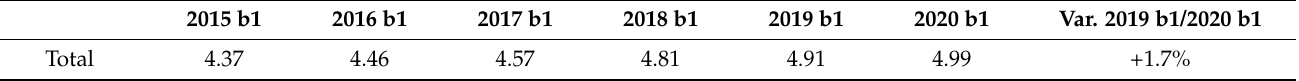
Figure 3. Number of EAN codes of 0.75 liter bottles sold.